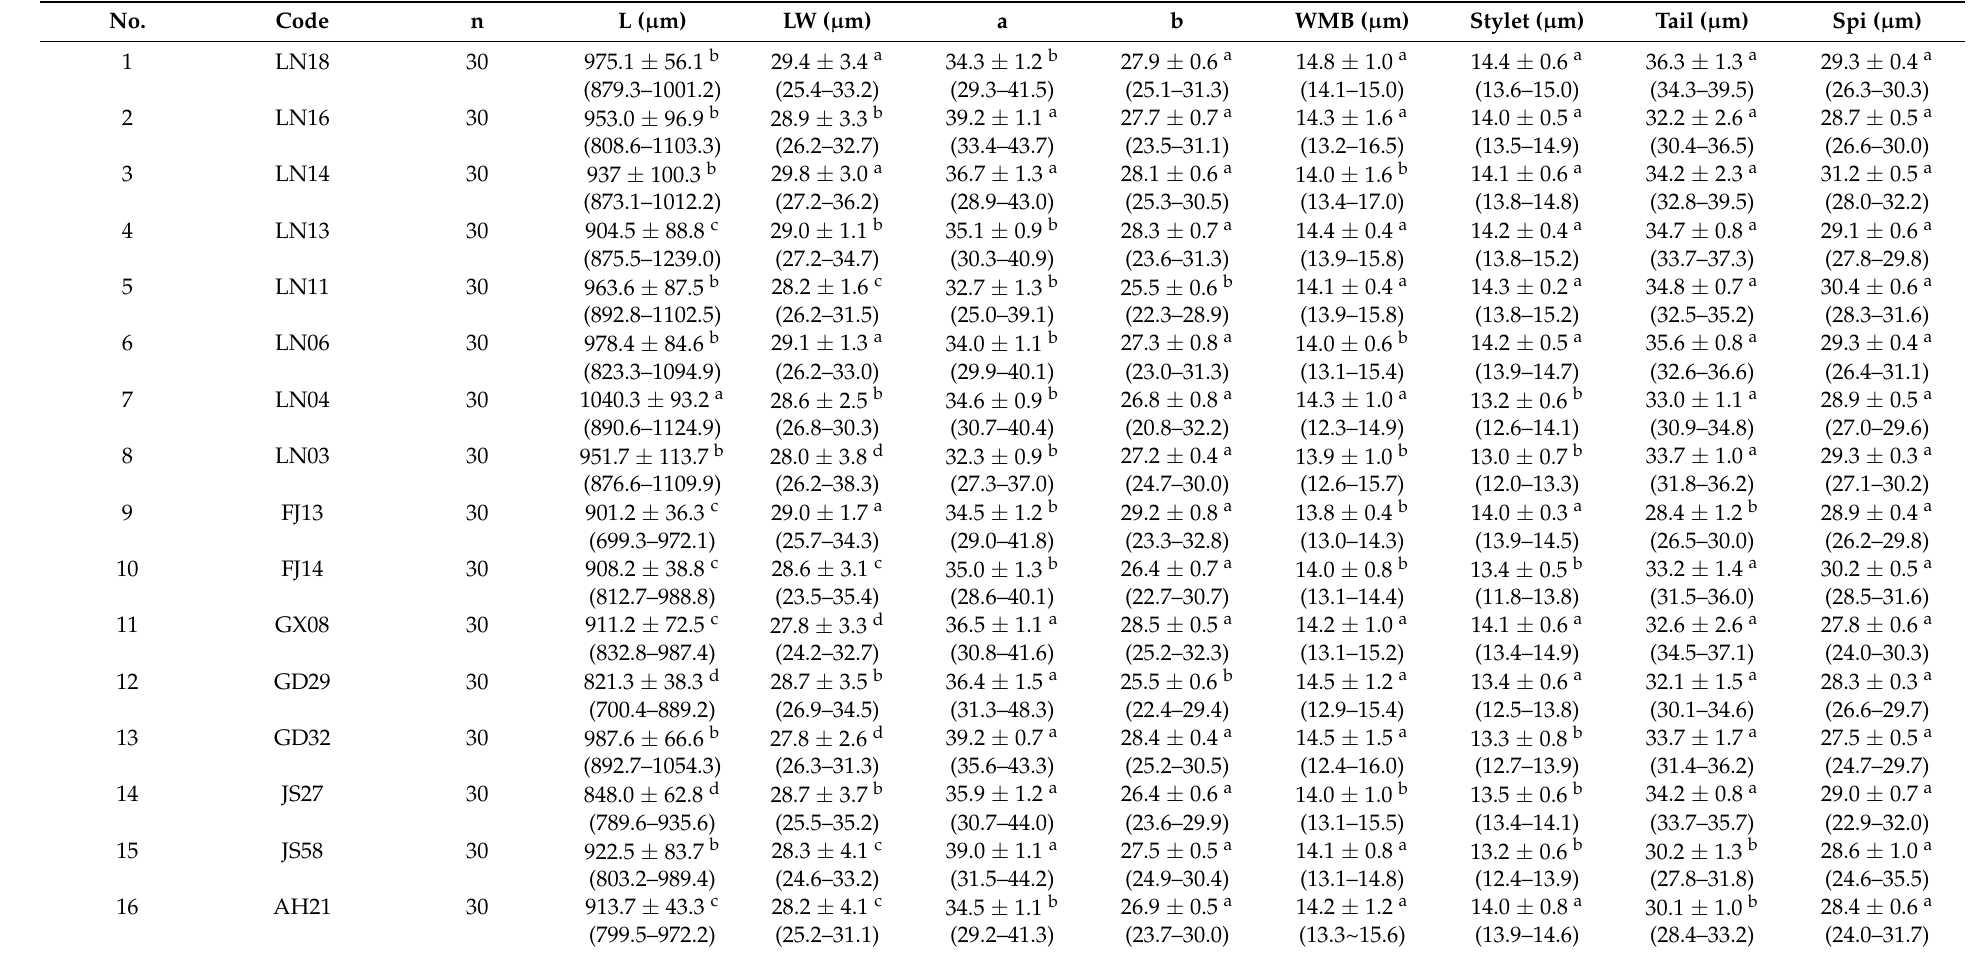
Table 4. Morphometrics of male nematodes in north and south China. L is the body length ( µ m); LW is the maximum body width ( µ m); a is the body length/maximum body width ratio; b is the body length/tail length ratio; WMB is the width of the middle esophageal bulb ( µ m); Stylet is the length of the stylus ( µ m); Spi is the length of the spicule ( µ m); Tail is the length of the tail ( µ